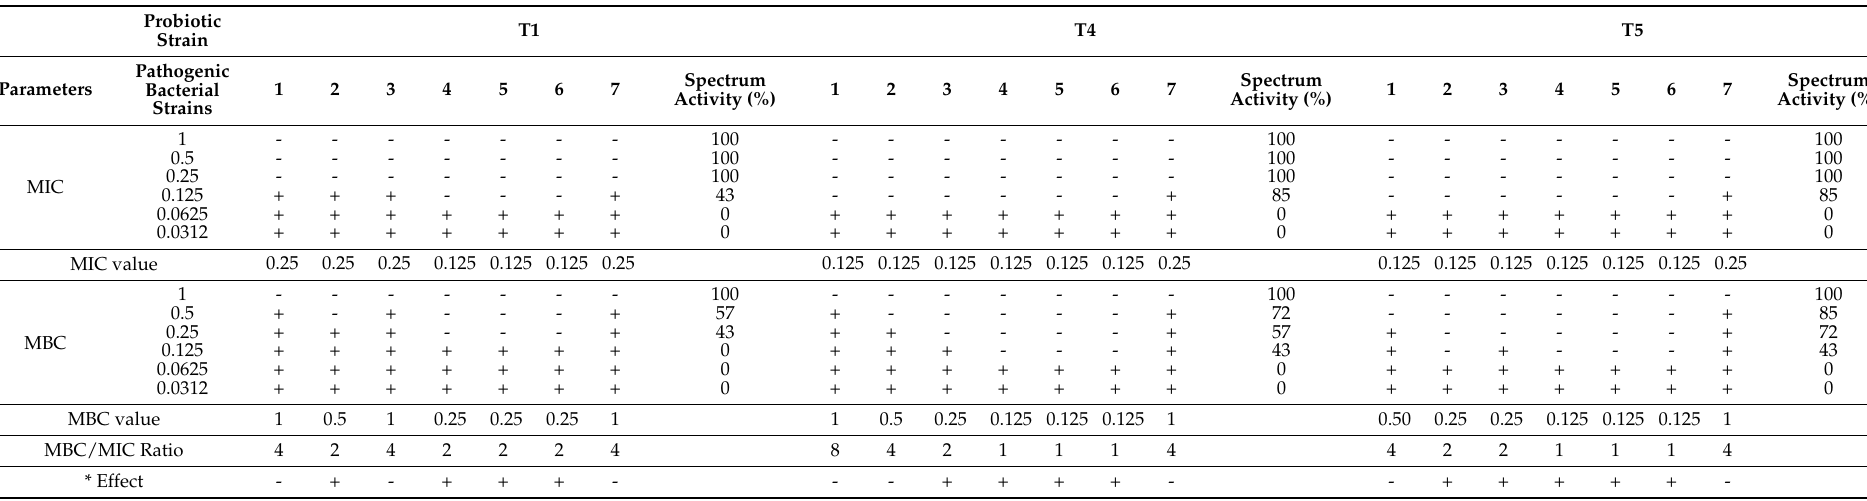
Table 1. Minimum inhibitory concentration (MIC) and minimum bactericidal concentration (MBC) of fermented soymilk product. Probiotic Strain